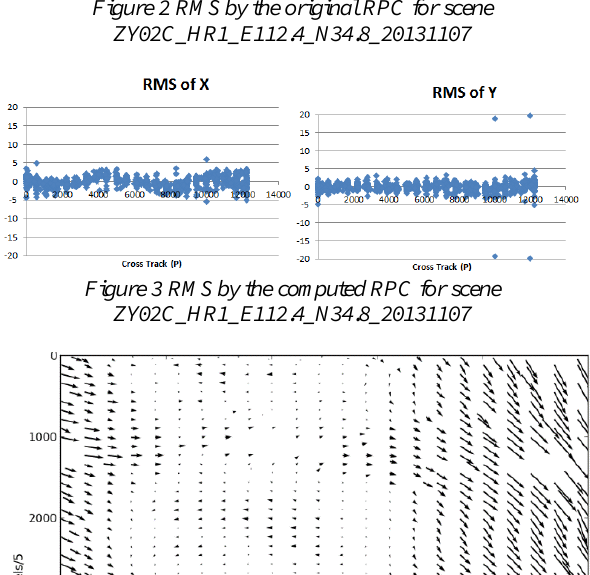
Figure 2 RMS by the original RPC for scene